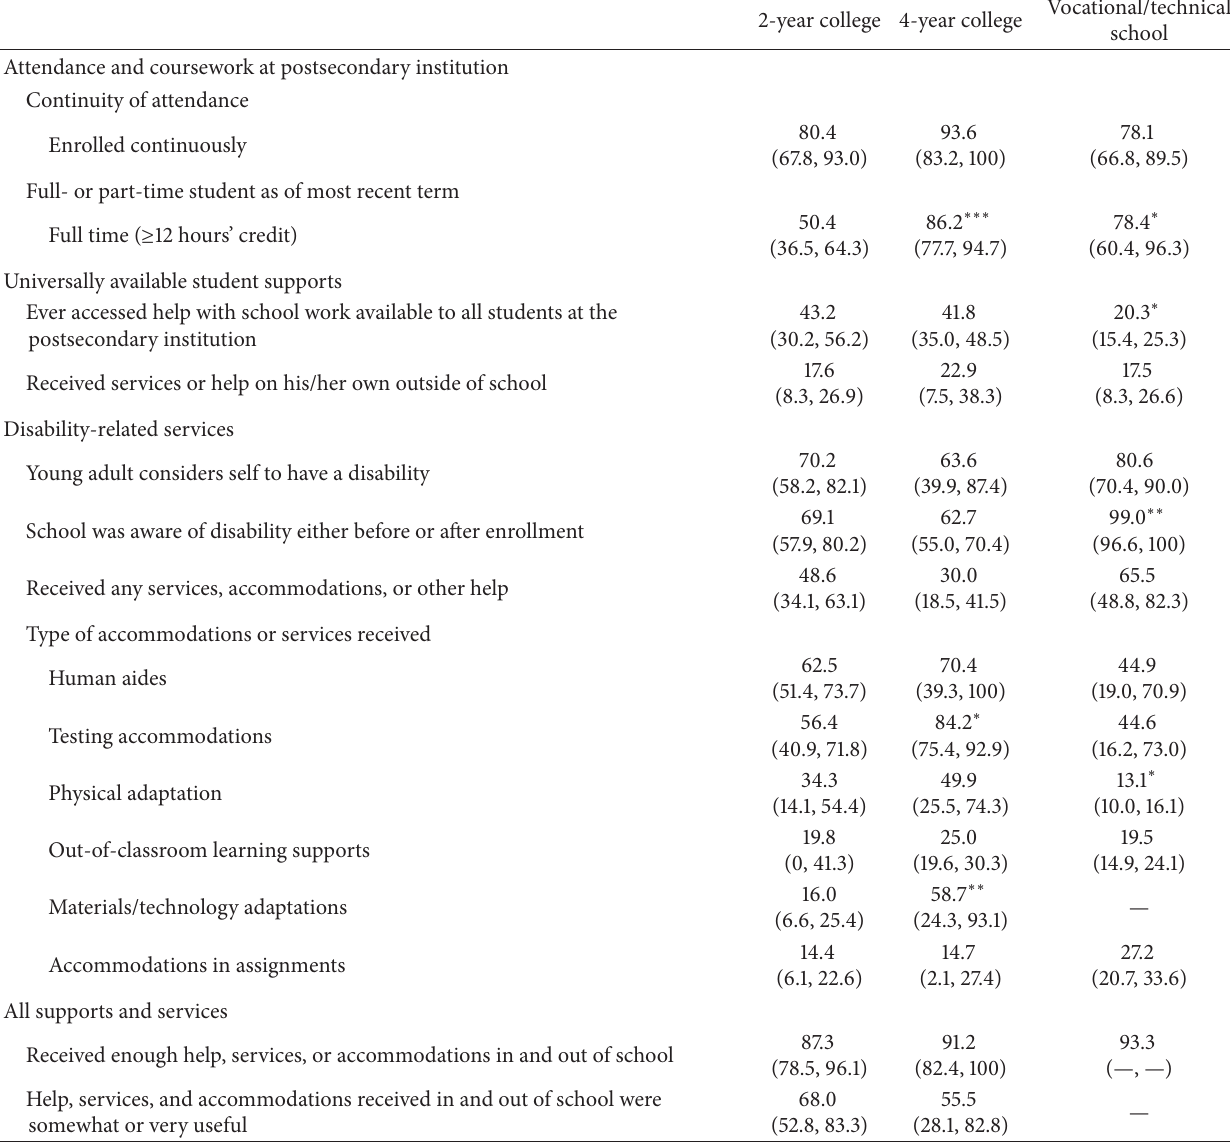
Table 2: Postsecondary education supports and services experiences of youth on the autism spectrum. Percentage (95% confidence interval), test for difference versus the 2-year college